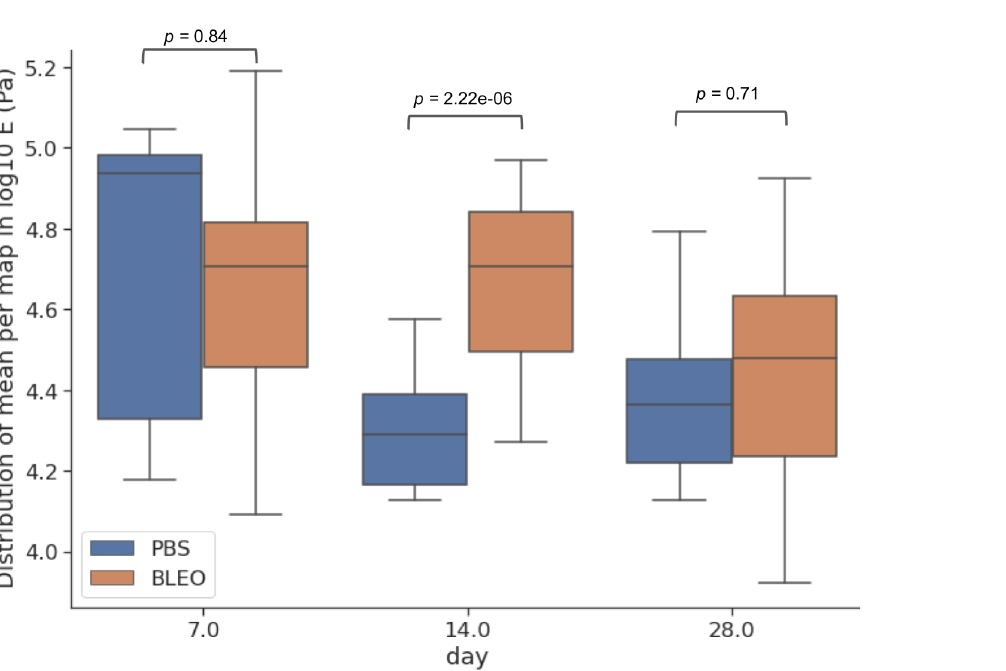
Figure 2. Young’s modulus EHR assessed by AFM through high-resolution maps. The centre line in the boxplots represents the median value, the top and bottom limits of the box represent Q1 and Q3 of the data. Whiskers represent minimum and maximum value of the data, the diamonds represent the outliers and are data points outside 1.5 times the interquartile range. ( n = 9 for control and n = 21 for fibrotic, corresponding to 3 maps per animal).